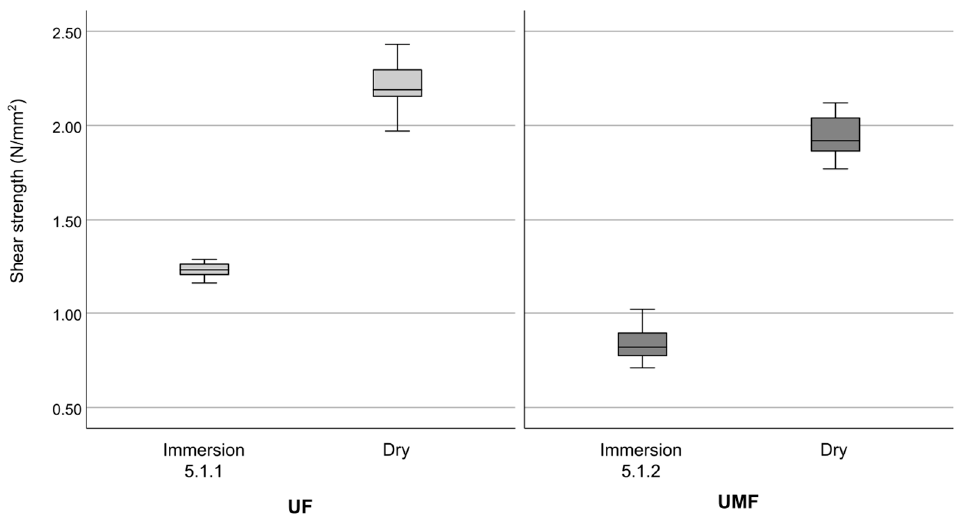
Figure 2. Shear strength of tested sandwich panels.